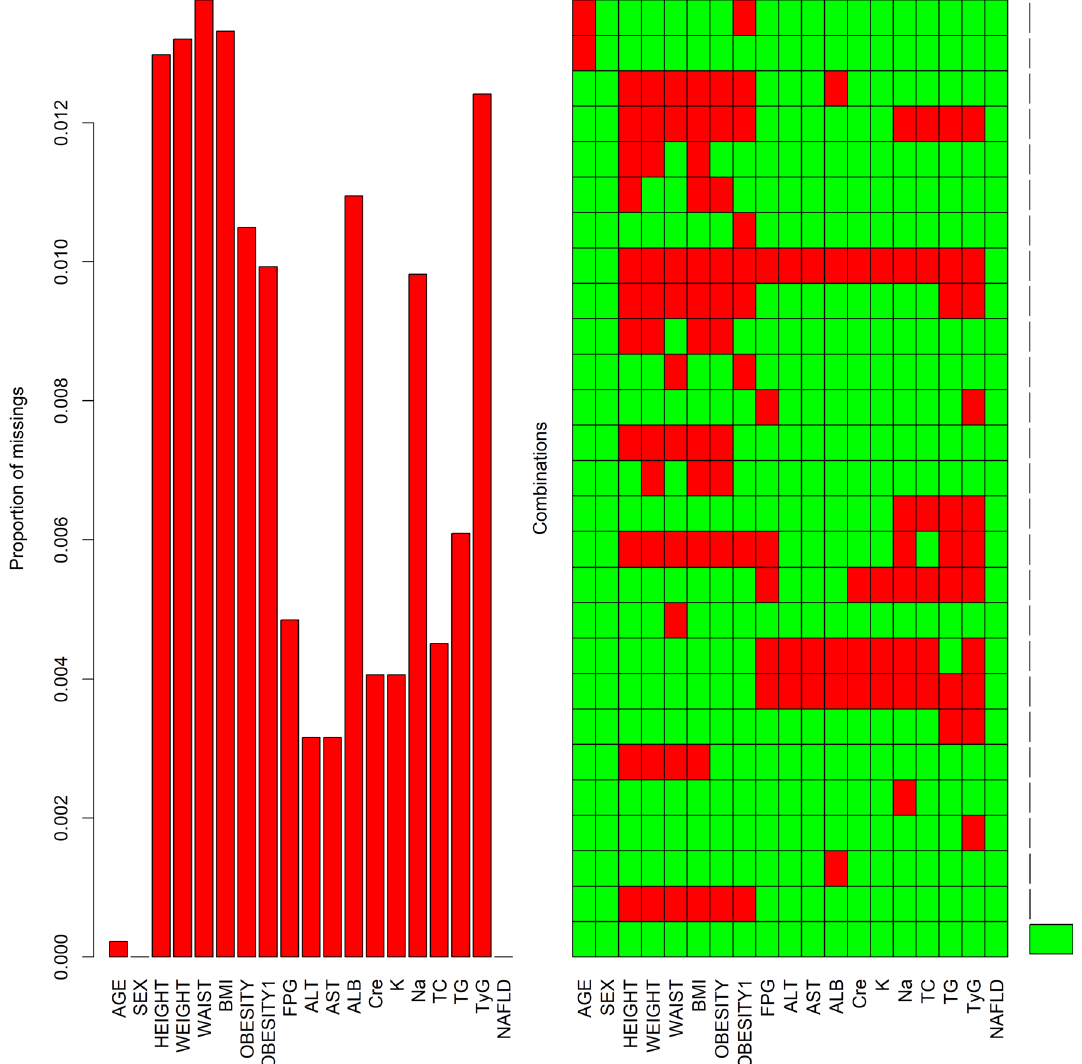
Figure 1. Missing values of variables. BMI body mass index, FPG fasting plasma glucose, ALT alanine aminotransferase, AST aspartate aminotransferase, ALB albumin, Cre creatinine, TC total cholesterol, TG triglycerides, TyG triglycerides and glucose index, NAFLD nonalcoholic fatty liver disease. Obesity: BMI ≥ 25.0 kg/m 2 ; obesity1: WC > 80 cm for female or WC > 90 cm for